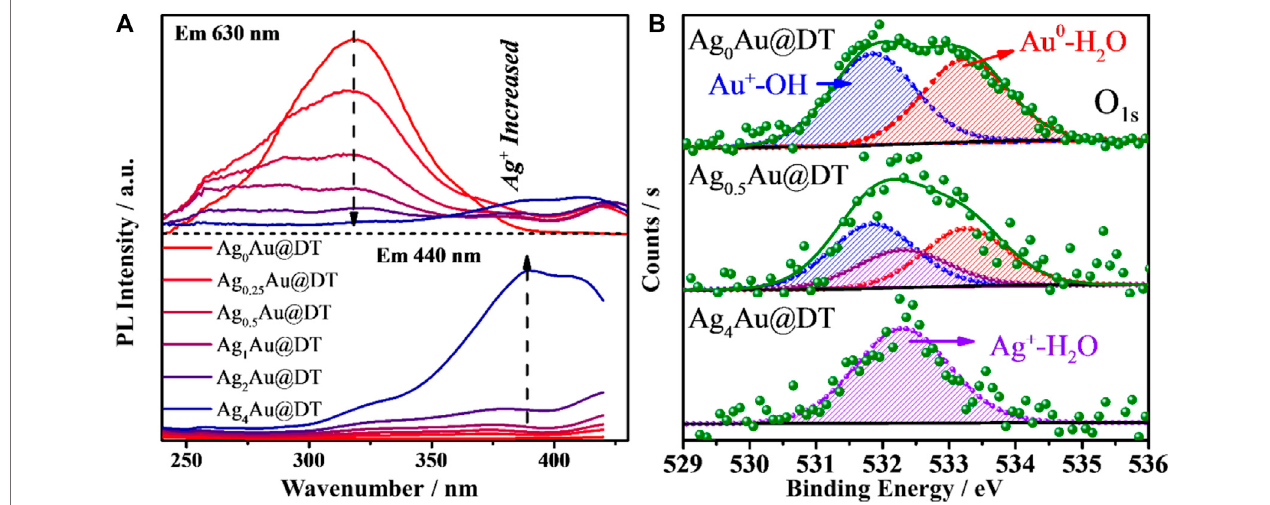
FIGURE 4 | Excitation spectra (A) of Ag x Au@DT NCs and XPS spectrum (B) of O 1s for Ag 0 Au@DT and Ag 0.5 Au@DT and Ag 4 Au@DT NCs.